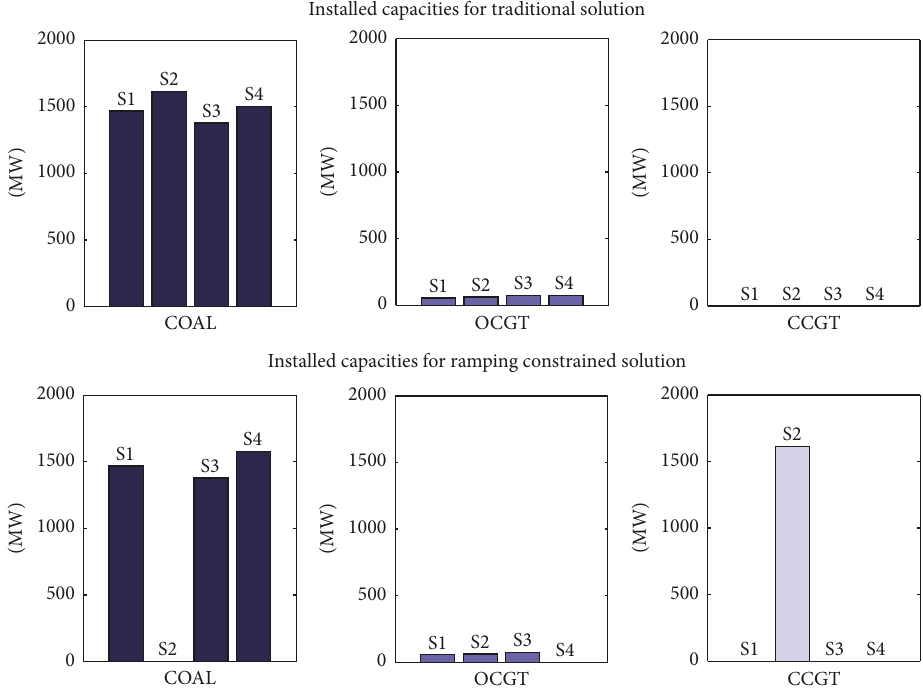
Figure 5: Traditional and ramping constrained installed capacities for each scenario.